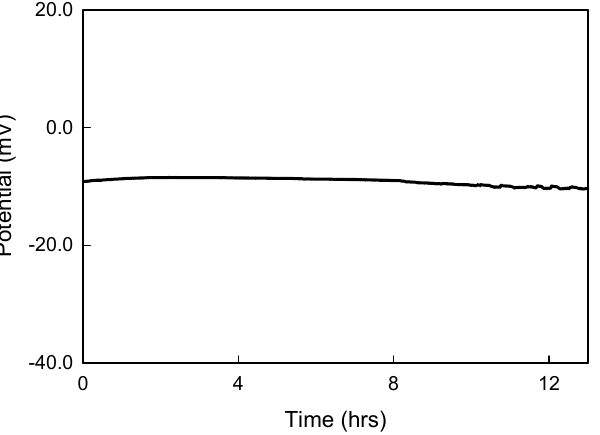
Figure 2. Potential of a solid-contact reference electrode with a plasticized PVC mixed with KCl layer was recorded in 0.1 M KCl as a function of time.